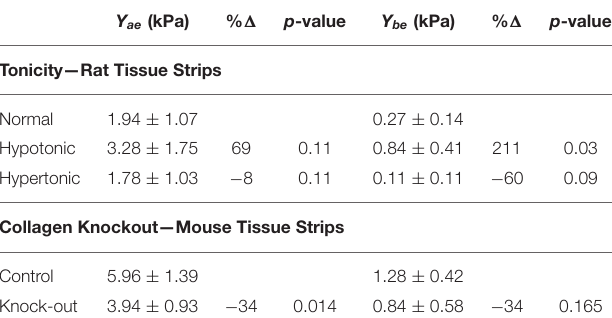
TABLE 1 | Model validation experimental results.